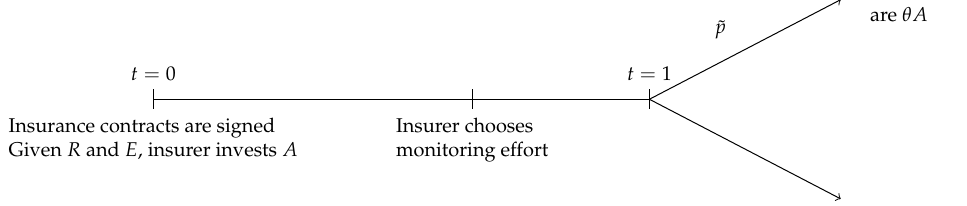
Figure 1. Timeline without systemic